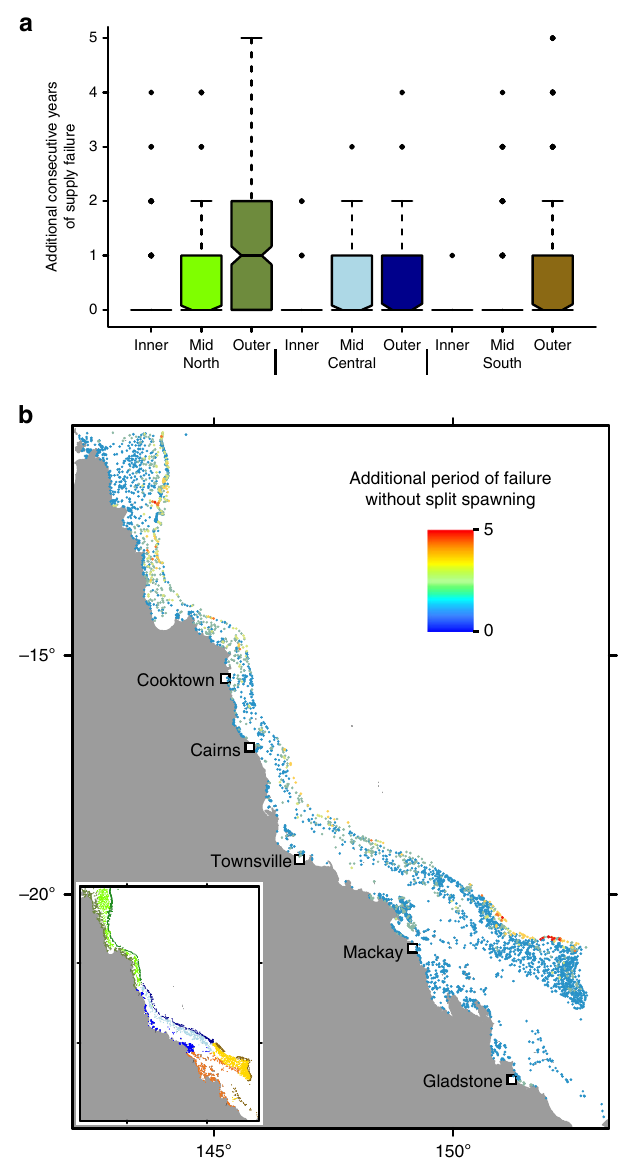
Fig. 5 Effects of split spawning on the reliability of larval supply over time. Prolongation of the period during which supply fails without split spawning ( a ) by sector, and ( b ) as a continuous map. To guide interpretation, if a reef experienced two consecutive years of failed larval supply and split spawning prevented it from experiencing a third, then the ‘ additional consecutive years of supply failure ’ would be 1. The maximum number of consecutive years in all analyses was 7. The colours of the boxes in ( a ) correspond to the colour scheme of the GBR sectors shown in the inset in ( b ). In the boxplot, the centre line represents the median, the upper and lower limits of the box represent the third and fi rst quartile respectively, the notches in the boxes represent the con fi dence interval around the median (equal to ±1.58 times interquartile range divided by square root of the sample size), the whiskers extend up to 1.5 times the interquartile range from the bounds of the box, and the points represent outliers beyond the limits of the whiskers. In ( b ) blue hues show reefs that would not have a prolonged period of supply failure without split spawning, and red hues show the reefs that would have up to 5 additional consecutive years